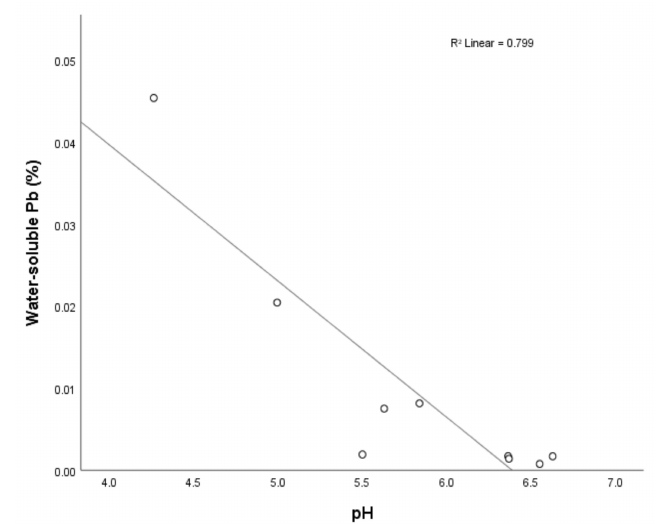
Figure 5. Relationship between soil pH and water extractable Pb ( p = 0.001). Note: y axes denote water extractable concentrations as a percentage of measured total soil concentrations. All values are derived from sample site